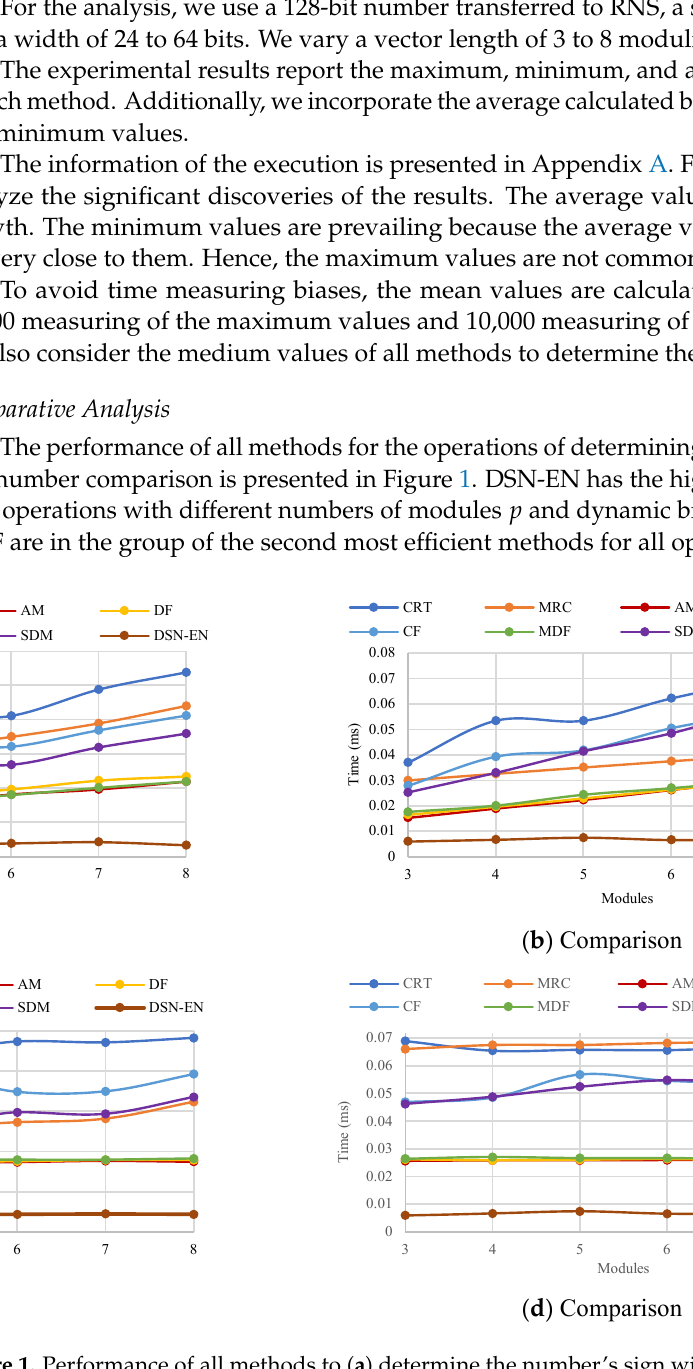
12 of 21 Algorithm 8: DSN-EN Input : ((cid:1876) (cid:2869) , (cid:1876) (cid:2870) , … , (cid:1876) (cid:3041) ) , ((cid:1868) (cid:2869) , (cid:1868) (cid:2870) , … , (cid:1868) (cid:3041) ) , and (cid:3435)(cid:1875) (cid:2869),(cid:2870) , (cid:1875) (cid:2869),(cid:2871) , … , (cid:1875) (cid:3041),(cid:3041) (cid:3439) Output : (cid:1845) 1 for (cid:1861) = 1 to (cid:1866) do 1.1 for (cid:1862) = (cid:1861) + 1 to (cid:1866) do 1.1.1 (cid:1876) (cid:3037) = (cid:3627)(cid:3435)(cid:1876) (cid:3037) − (cid:1876) (cid:3036) (cid:3439) ⋅ (cid:1875) (cid:3036),(cid:3037) (cid:3627) (cid:3043) (cid:3285) 2. if (cid:4698)2 ⋅ (cid:3051) (cid:3289) (cid:3043) (cid:3289) (cid:4698) < 1 : 2.1 (cid:1845) = 1 4. else : 4.1 (cid:1845) = 0